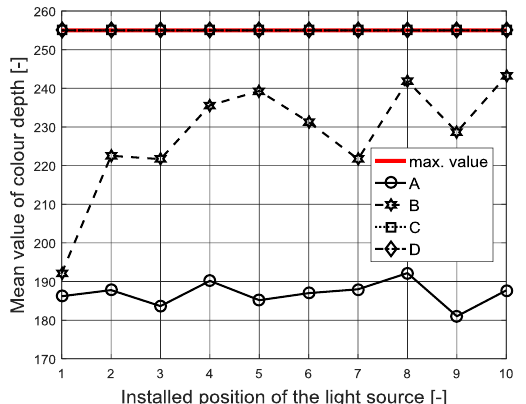
Fig. 5. Mean colour value of background – effect of light source position, shutter speed = 10  s (0 = total black colour, 255 = total white colour).